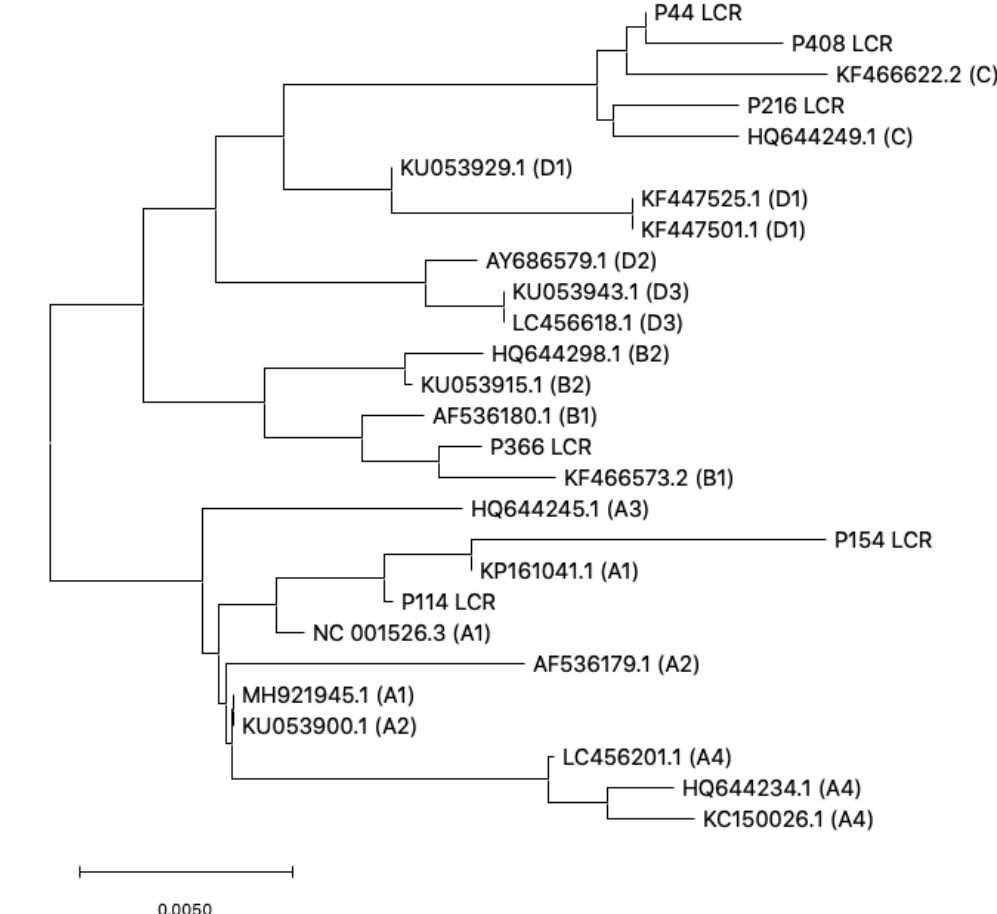
Figure 5. Evolutionary relationships of HPV16 lineages/sublineages in Kinshasa based on LCR region. The evolutionary history was inferred using the Neighbor-Joining method [37]. The tree is drawn to scale, with branch lengths in the same units as those of the evolutionary distances used to infer the phylogenetic tree. The evolutionary distances were computed using the Maximum Composite Likelihood method [38] and are in the units of the number of base substitutions per site. The analysis involved 27 nucleotide sequences (21 reference strains from GenBank and 6 new sequences from this study). Codon positions included were 1st + 2nd + 3rd + Noncoding. All positions containing gaps and missing data were eliminated. There was a total of 985 positions in the final dataset. Evolutionary analyses were conducted in MEGAX